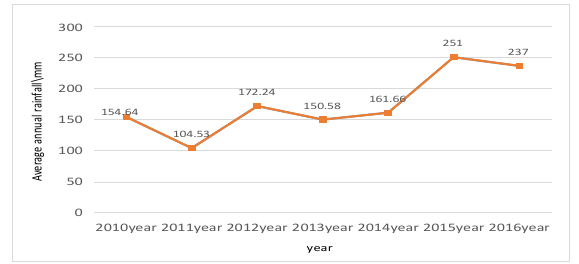
Figure 4-5 changes of annual average rainfall in Guilin from 2010 to 2016